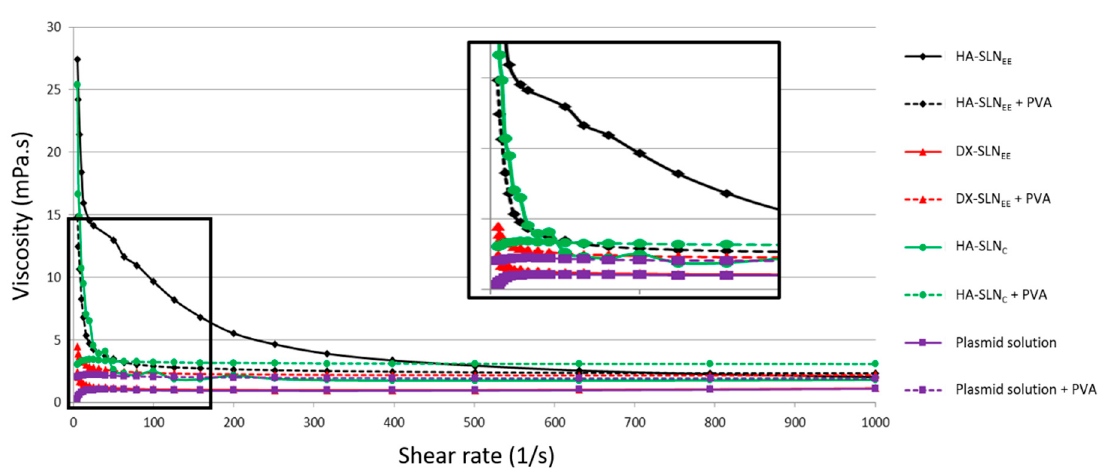
Figure 2. Viscosity curve at shear rates from 5 to 1000 s − 1 of water, the solution of plasmid pcDNA3-EGFP and vectors, with and without PVA. PVA: polyvinyl alcohol; HA: hyaluronic acid; DX: dextran; SLN: solid lipid nanoparticle.